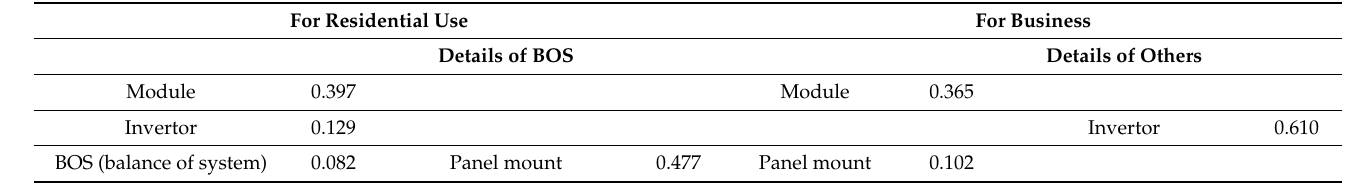
Table A3. Cost composition of solar power-generation equipment/facility